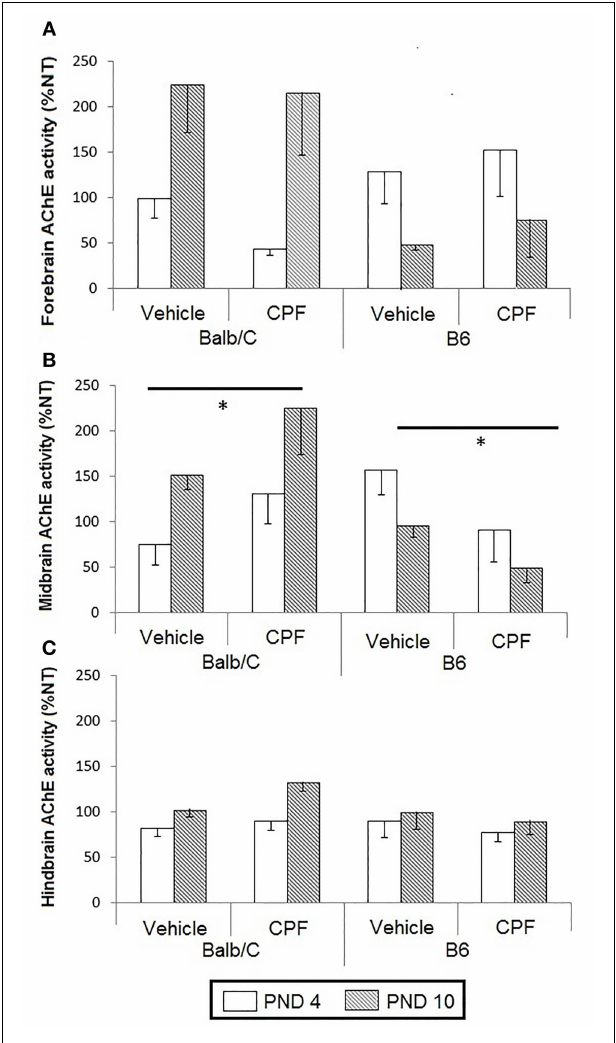
FIGURE 2 | AChE activity in pup brain expressed as percent of the corresponding NT group (Mean–SEM). (A) Forebrain, (B) Midbrain, (C)